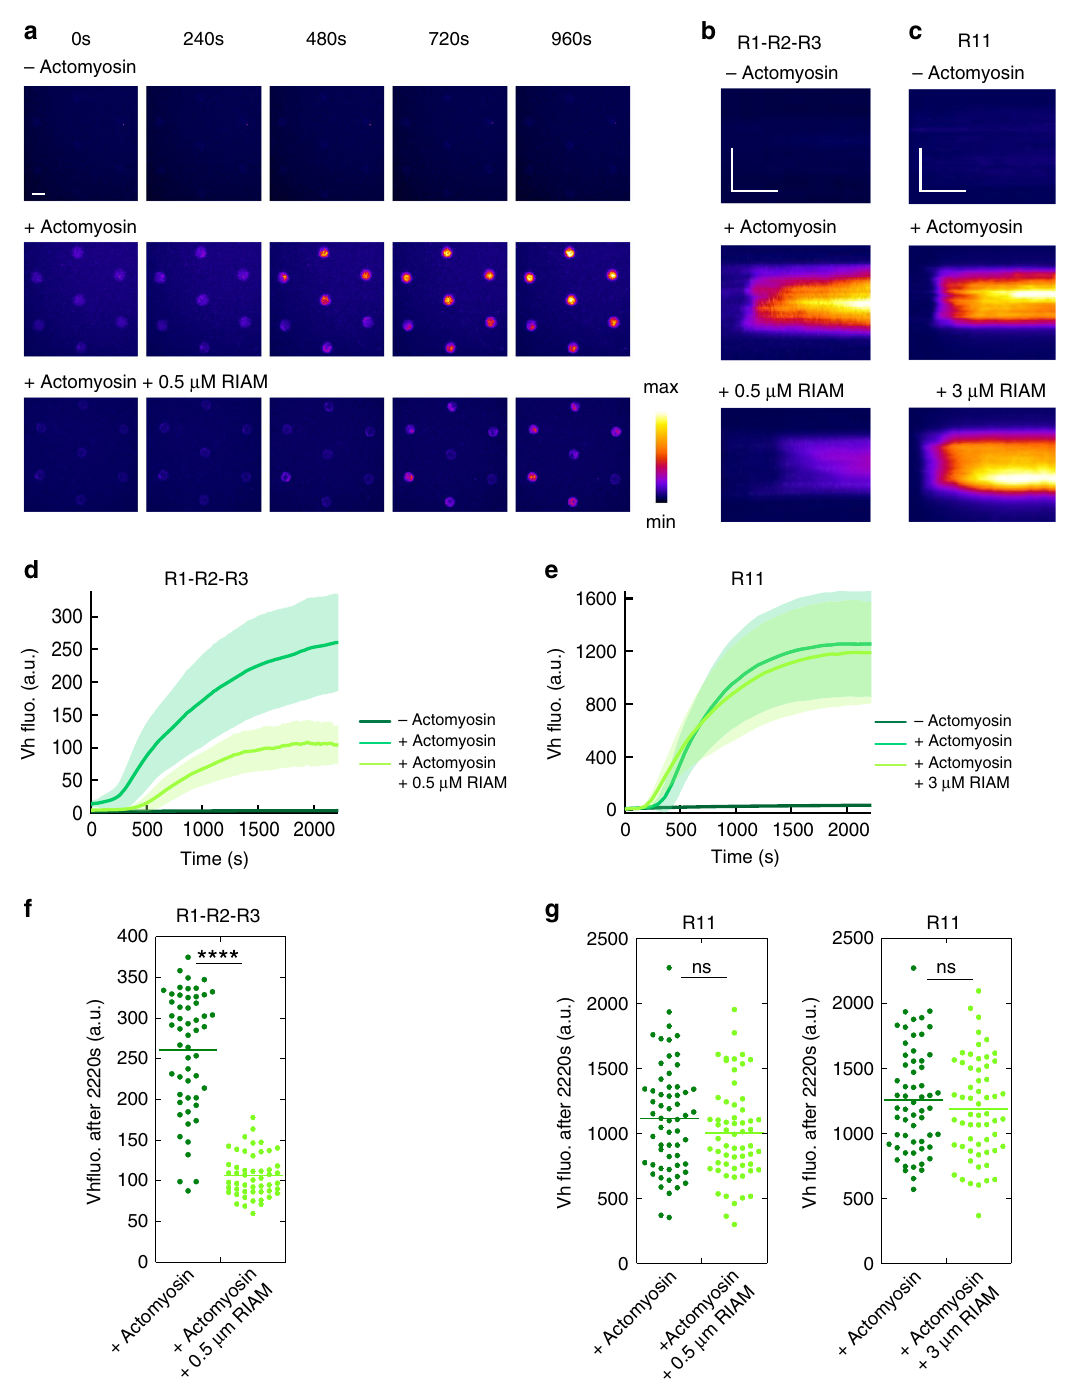
Fig. 5 RIAM inhibits the actomyosin-dependent binding of vinculin to talin R1 – R2 – R3 but not to R11. a Time lapse showing the recruitment of Vh in disks coated with talin R1 – R2 – R3 in the absence of actomyosin (top), presence of actomyosin (middle), and presence of actomyosin and RIAM (bottom). This experiment was repeated twice independently with the same results. b , c Kymographs of EGFP-Vh along a cross-section of a disk coated with talin R1 – R2 – R3 ( b ) and R11 ( c ). Conditions: 100 nM EGFP-Vh, 2.4 µ M actin, 50 nM myosin, 500 nM ( b ) or 3 µ M ( c ) mCherry-RIAM, 1 µ M talin during